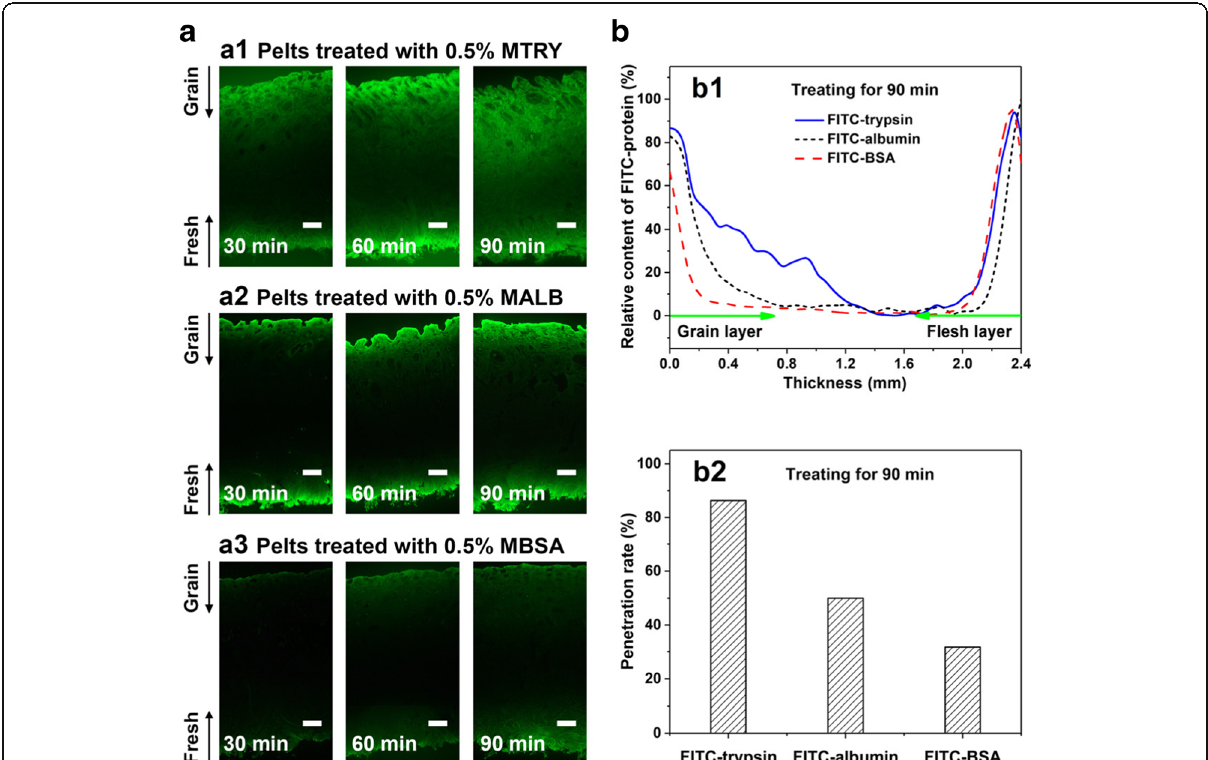
Fig. 9 ( a ) Fluorescence micrographs of vertical sections from pelts (bar = 500 μ m) treated with the mixture of trypsin and FITC-trypsin (MTRY) (a1), the mixture of albumin and FITC-albumin (MALB) (a2) and the mixture of BSA and FITC-BSA (MBSA) (a3); ( b ) relative contents (b1) and penetration rates (b2) of FITC-trypsin, FITC-albumin and FITC-BSA in the pelts treated for 90min (obtained by analysis of (a) using Image J